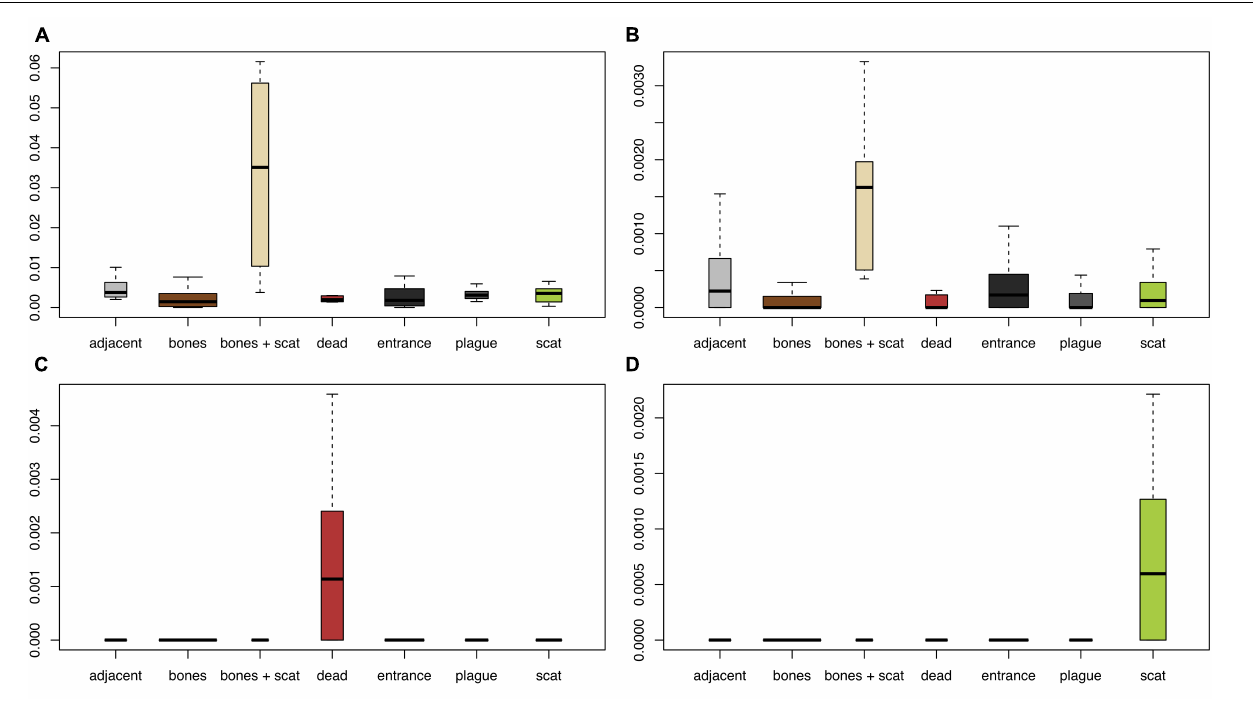
FIGURE 3 | Variation in relative abundance of four representative microbial taxa among regions of the prairie dog burrow. (A) An unknown family and genus in the AKIW781 order of class Chloroflexi, (B) Deinococcus (Deinococcaceae), (C) an unknown genus in Planococcaceae, and (D) Cellulosimicrobium (Promicromonosporaceae, Actinomycetales). Y -axes are the percentage of total microbial sequences that comprise represented taxa. Width of boxes represents relative sample